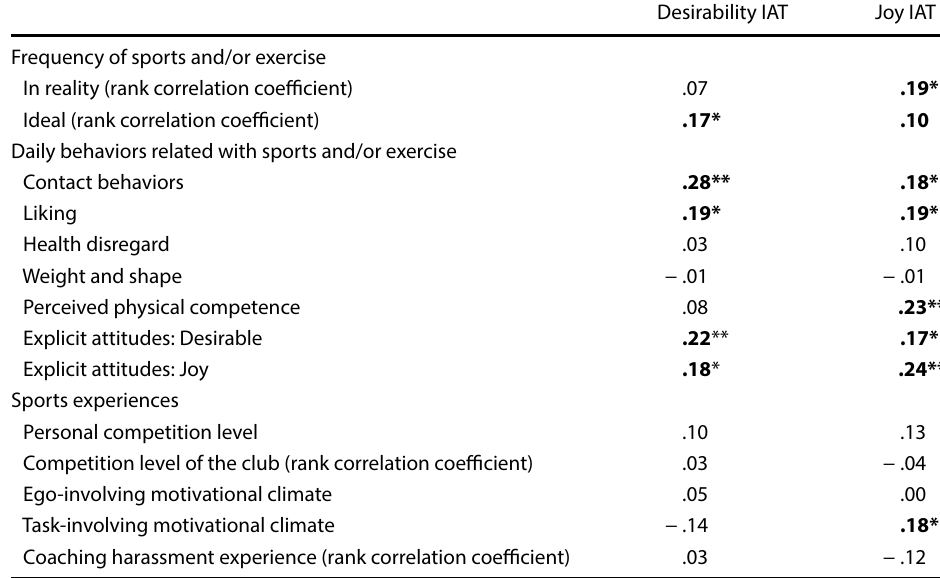
Table 3 Correlations with the IAT